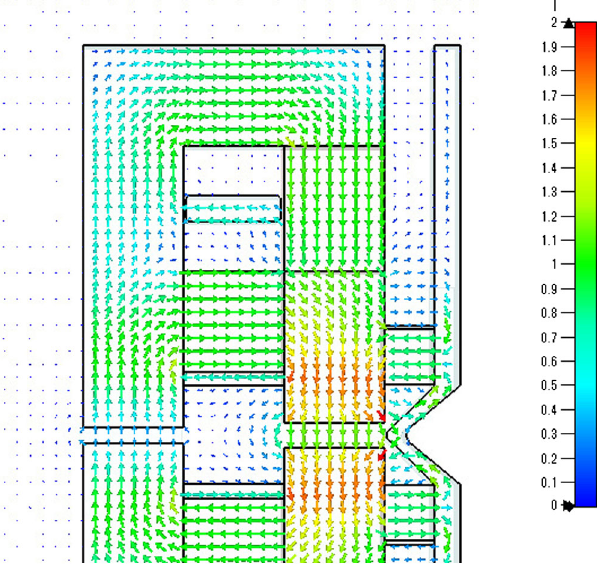
FIG. 4. Magnetic flux density (B) distribution at the central cross section in the beam direction.